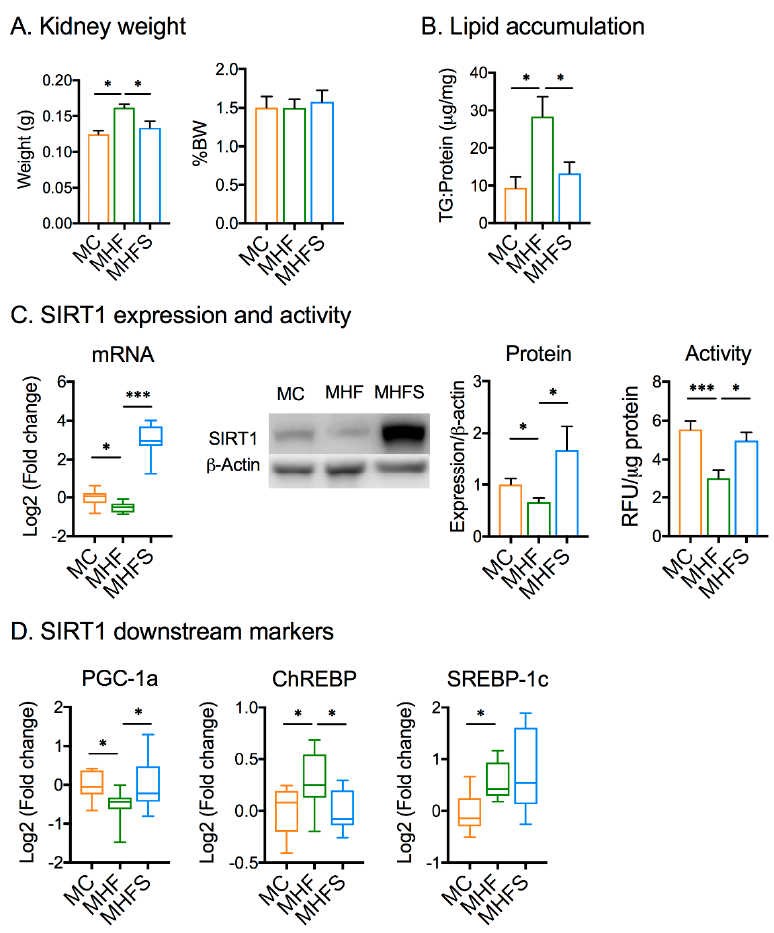
Figure 2. SIRT1 overexpression reduces kidney weight and lipid accumulation in offspring born to obese dams. ( A ) Kidney weight ( n = 11–26). ( B ) Kidney triglyceride level ( n = 6). ( C ) SIRT1 expression and activity ( n = 6). ( D ) The expression of downstream markers of SIRT1 ( n = 6). Data are expressed by mean ± SEM or box plot (min to max, the central lines indicate the median). SIRT: sirtuin; PGC-1 α : peroxisome proliferator-activated receptor gamma coactivator 1 alpha; SREBP-1c: sterol regulatory element-binding protein, ChREBP: carbohydrate-responsive element-binding protein; MC: offspring of chow-fed dams; MHF: offspring of HFD-fed dams; MHFS: MHF offspring with SIRT1 overexpression. * p < 0.05, *** p < 0.001.